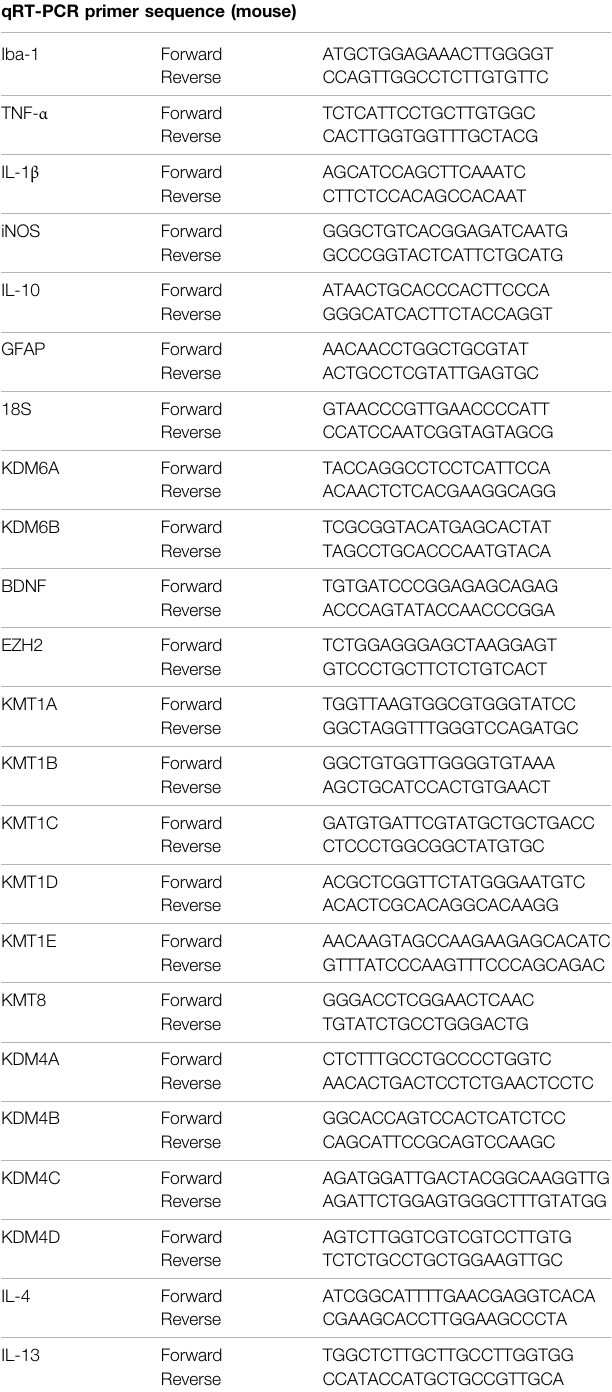
TABLE 2 | Primer sequences used for qRT-PCR